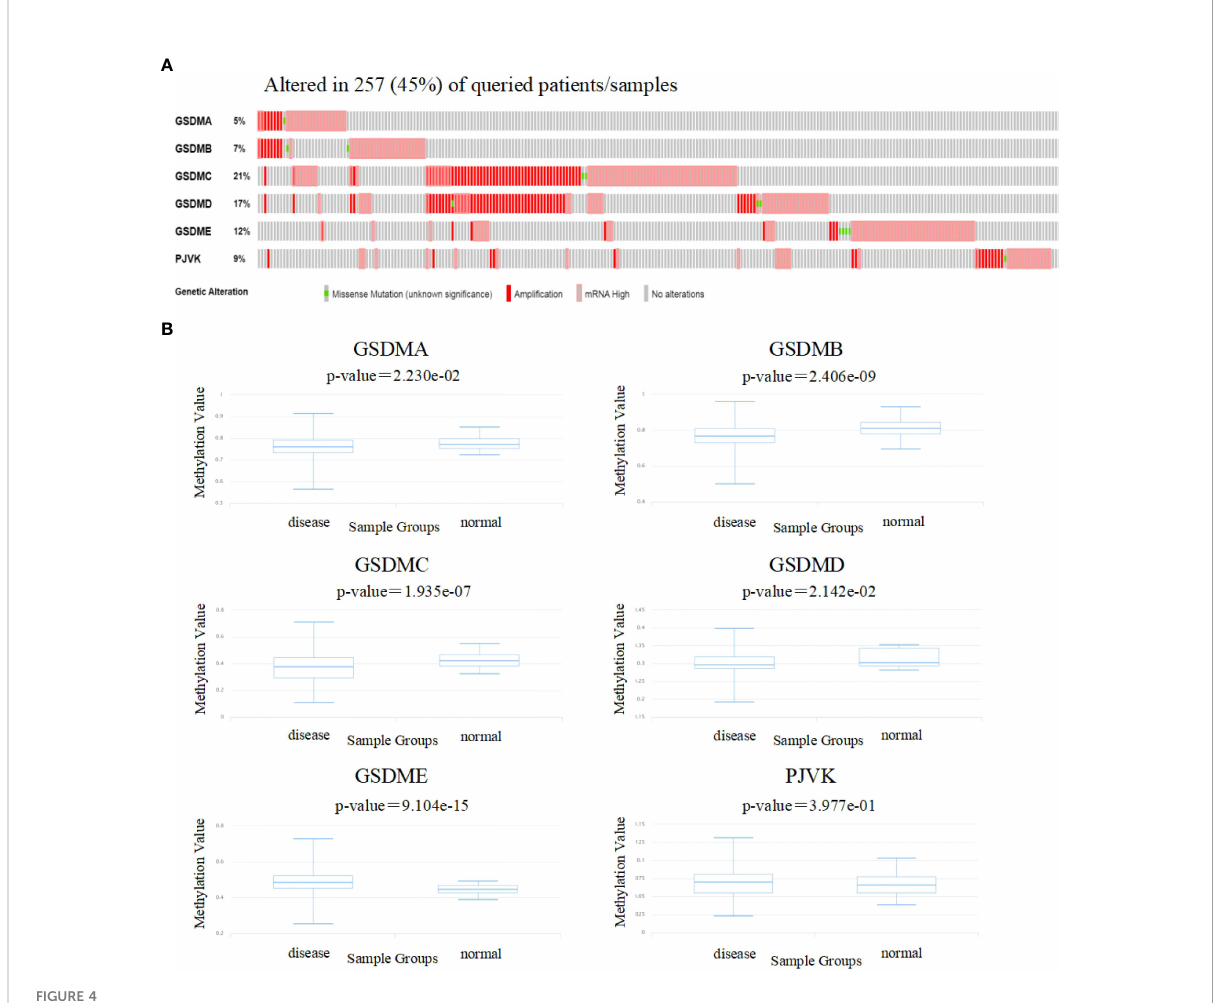
FIGURE 4 Genetic alterations and methylation levels of GSDM family members in LUAD. (A) The cBioPortal database was used to achieve the genetic alteration pro fi les of GSDMs. (B) The DiseaseMeth database was used to evaluate the DNA methylation levels of GSDM family members in